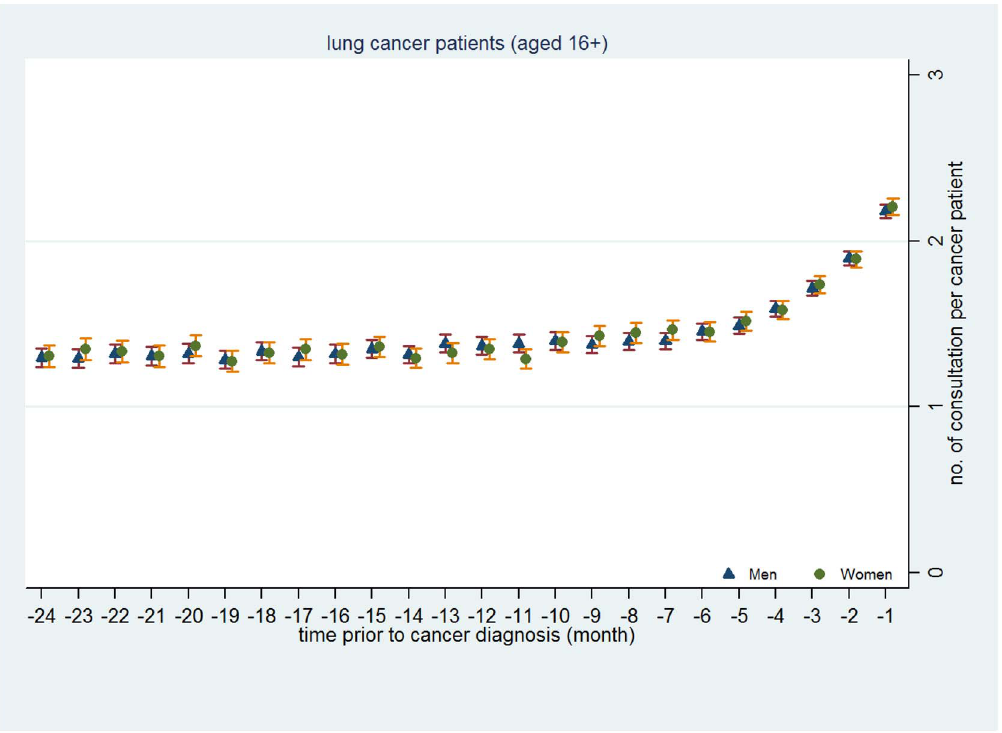
Figure 5. Mean number of primary care consultations per lung cancer patient made prior to cancer diagnosis by month and gender. doi:10.1371/journal.pone.0101562.g005 PLOS ONE |